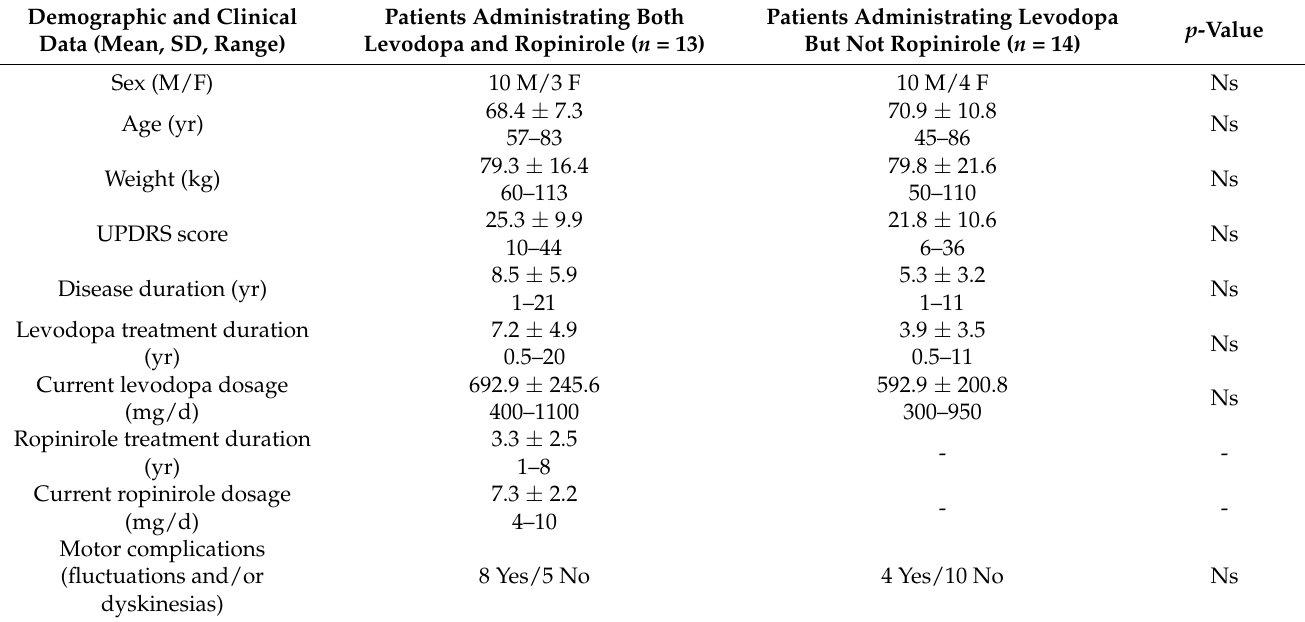
Table 1. Demographic data of patients administrating both levodopa and ropinirole, and patients administrating levodopa but not ropinirole.